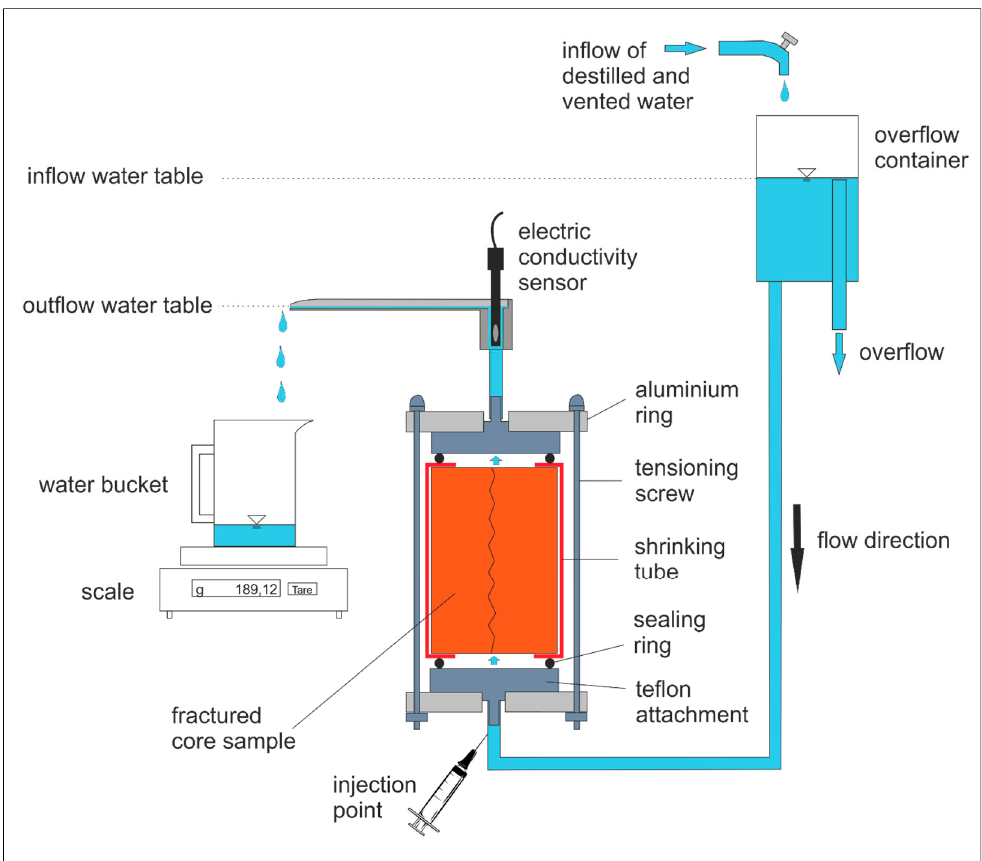
Figure 4. Schematic sketch of the experimental setup.